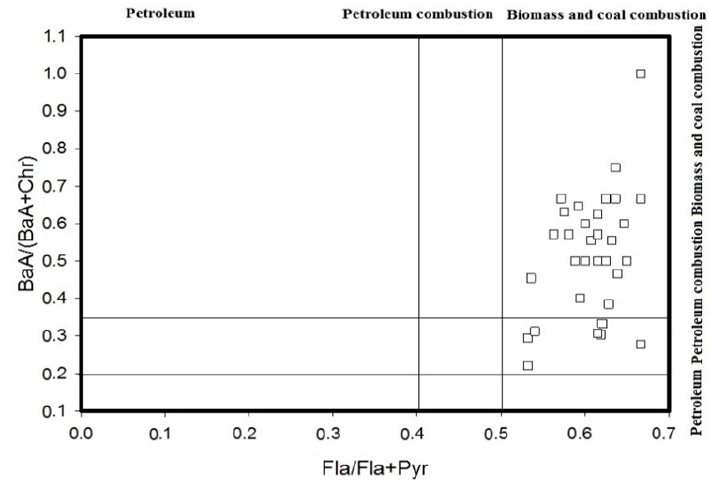
Figure 5. Source identifications of PAHs in soils of the Momoge Wetland